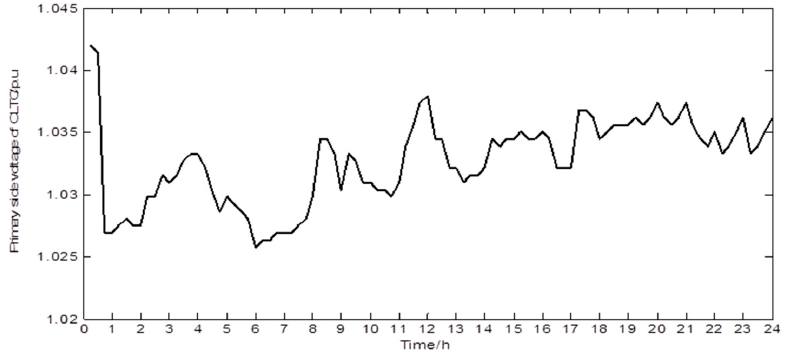
Figure 6. Primary side voltage of the on-load tap changer (OLTC).